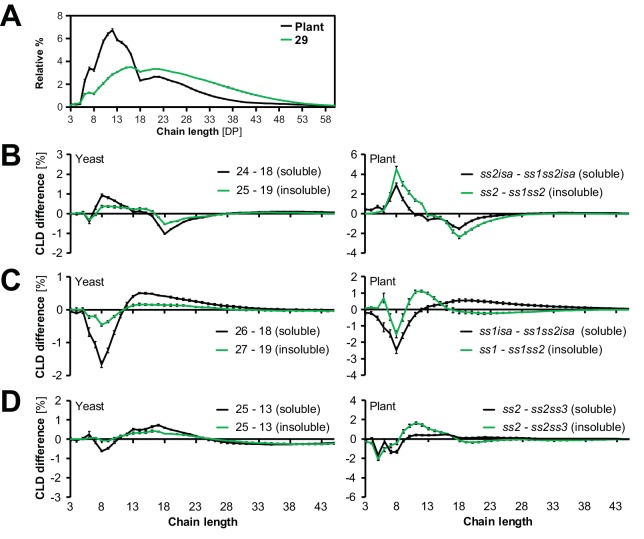
Starch synthases retain their chain-elongation specificities.(A) Chain length distributions (CLDs) of debranched insoluble glucans from line 29 and of wild-type Arabidopsis starch (WS ecotype). Values are means ± S.D. from 4 replicate yeast cultures or 3 plants, respectively. The CLD of gbss mutant Arabidopsis starch is reported to be identical to that from wild-type starch (Seung et al., 2015). (B-D) Representative graphs illustrating the changes in glucan fine structure upon the addition of SS1 (B), SS2 (C) or SS3 (D) in yeast and in planta. Comparisons were done by subtracting the CLDs as indicated (means ± S.E.M., n = 4, except for ss2isa, ss1isa, ss2, yeast line 13 (soluble) and ss2 [insoluble shown in B and D], where n = 3). Data from plants in B and C are recalculations from Pfister et al., (2014). Horizontal comparisons in yeast and in planta involve the same set of amylopectin-synthesizing genes in each case (i.e. line 24 has the whole known complement except for SS2 and ISA1/ISA2, corresponding to an ss2isa mutant; line 18 the same enzymes except for SS1, corresponding to an ss1ss2isa mutant). Subtracting the CLD of line 18 from that of line 24 thus reveals the effect of the presence of SS1.DOI:
http://dx.doi.org/10.7554/eLife.15552.01610.7554/eLife.15552.017Figure 5—source data 1.Numerical data of chain-length distributions from the plant and yeast glucans.